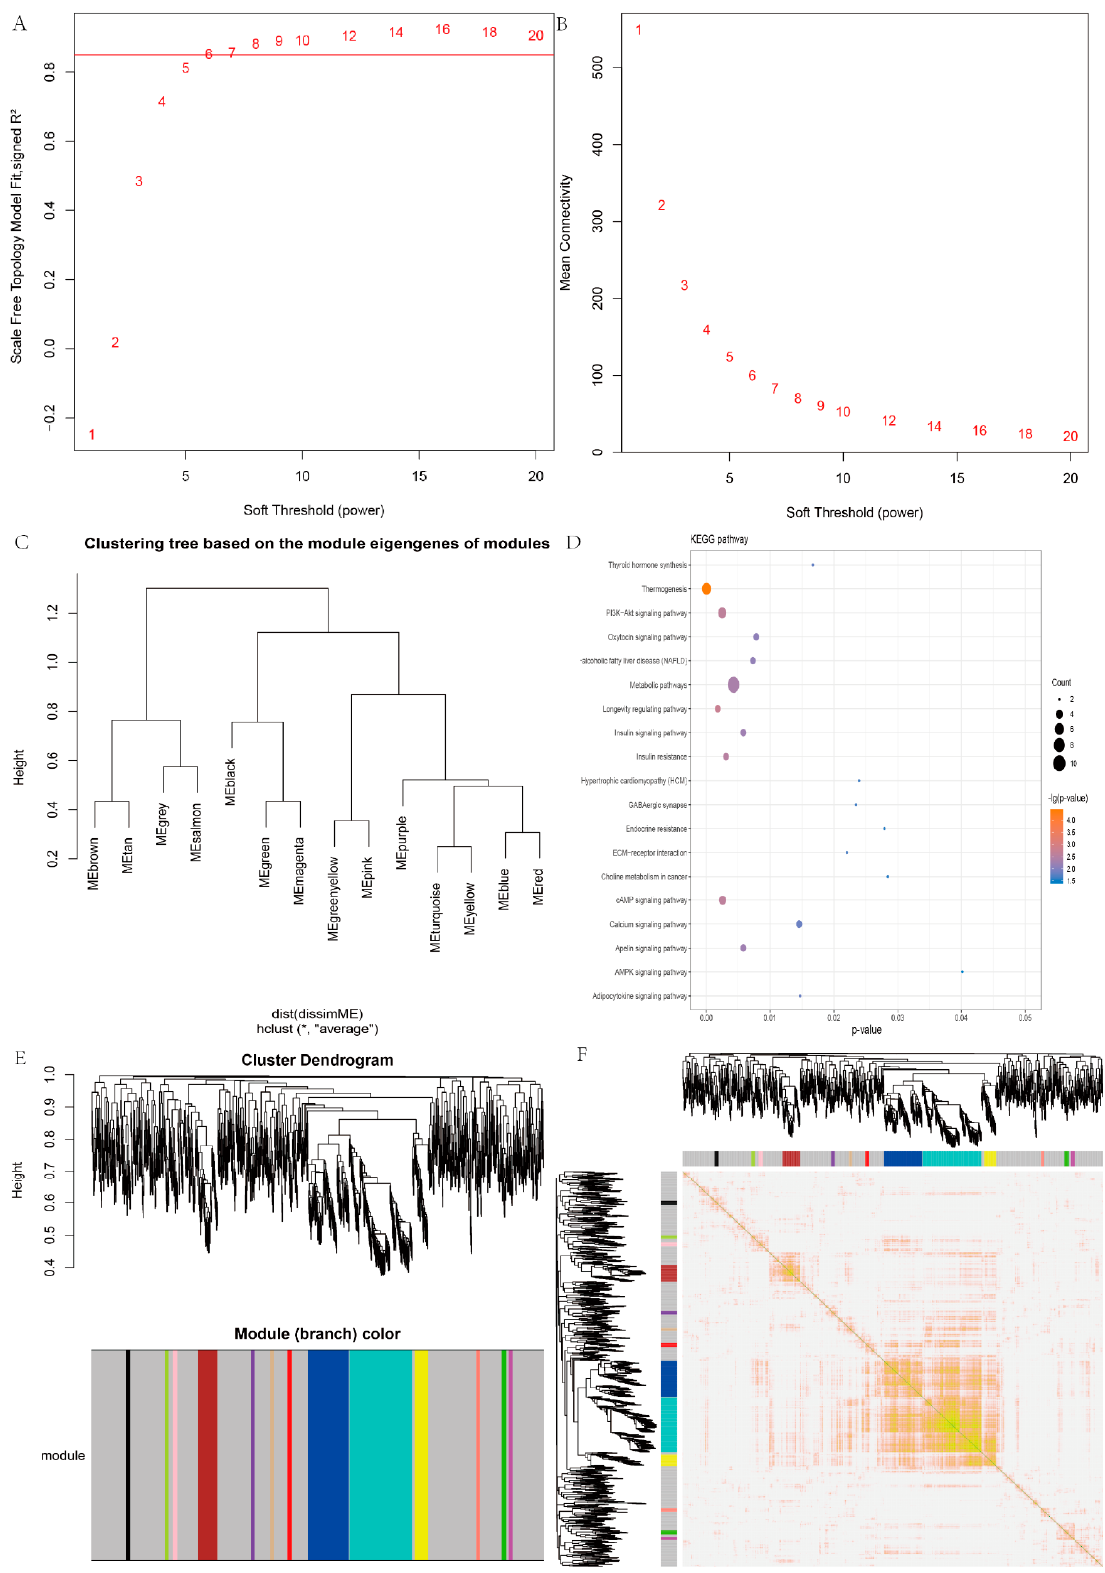
Figure 6. WGCNA of lncRNAs. ( A , B ) Calculating soft threshold; ( C ) clustering tree based on the module eigengenes of modules; ( D ) KEGG of the target gene of lncRNA in the turquoise module; ( E ) gene hierarchical clustering and module division; ( F ) correlation analysis of